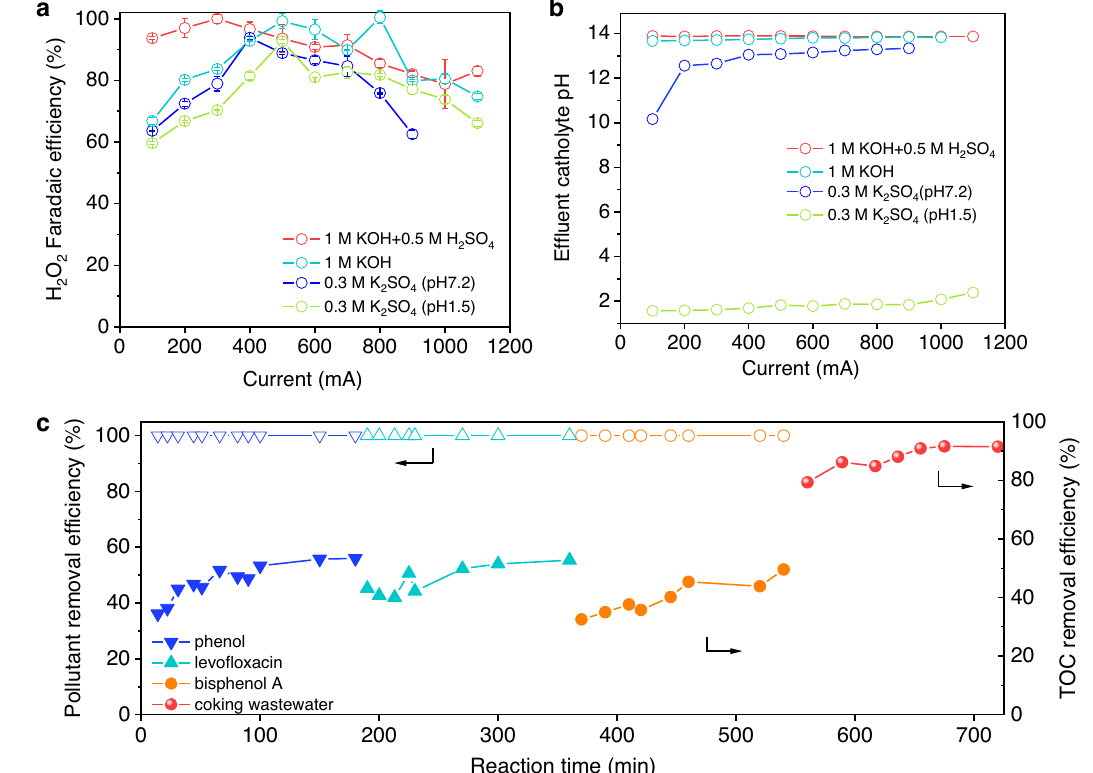
Fig.6|AcidicelectrosynthesisH 2 O 2 performanceandFentonapplications.a,b H 2 O 2 electrosynthesisemploying 1M KOH+0.5M H 2 SO 4 ,1M KOH+1MKOH,0.3M K 2 SO 4 +0.3 M K 2 SO 4 (pH 7.2 or 1.5) as catholyte and anolyte in the bigger fl ow-cell electrolyzer (test conditions: cathodic working area of 4cm − 2 , catholyte and ano- lyte fl owratesof82 – 100mLh − 1 ). c PollutantremovalandTOCremovalef fi ciencyby